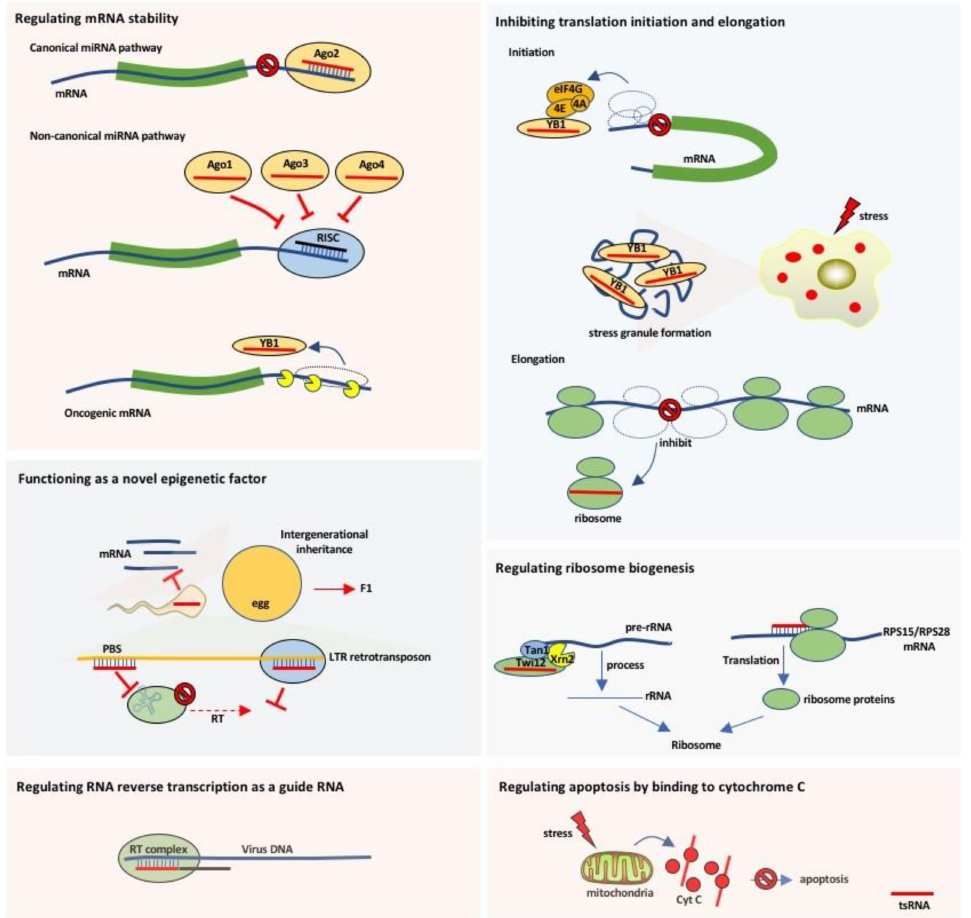
Figure 3. The diverse functions and working mechanisms of tsRNAs. It is generally accepted that the tsRNAs regulate a variety of biological processes, including gene expression, translation initiation and elongation, stress granule assembly, ribosome biogenesis, intergenerational inheritance, and apoptosis. miRNA: microRNA; RT: reverse transcription; LTR: long terminal repeat; RISC: RNA-induced silencing complex; PBS: primer binding sites; YB1: Y-box binding protein